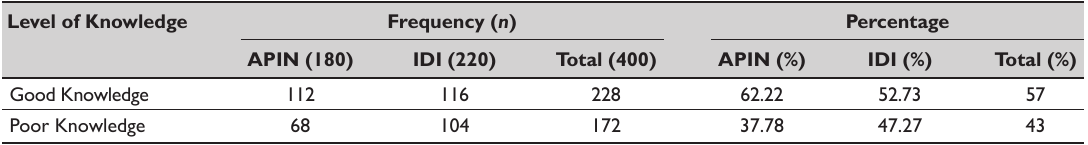
Table 2: Cumulative levels of knowledge among study participants Level of